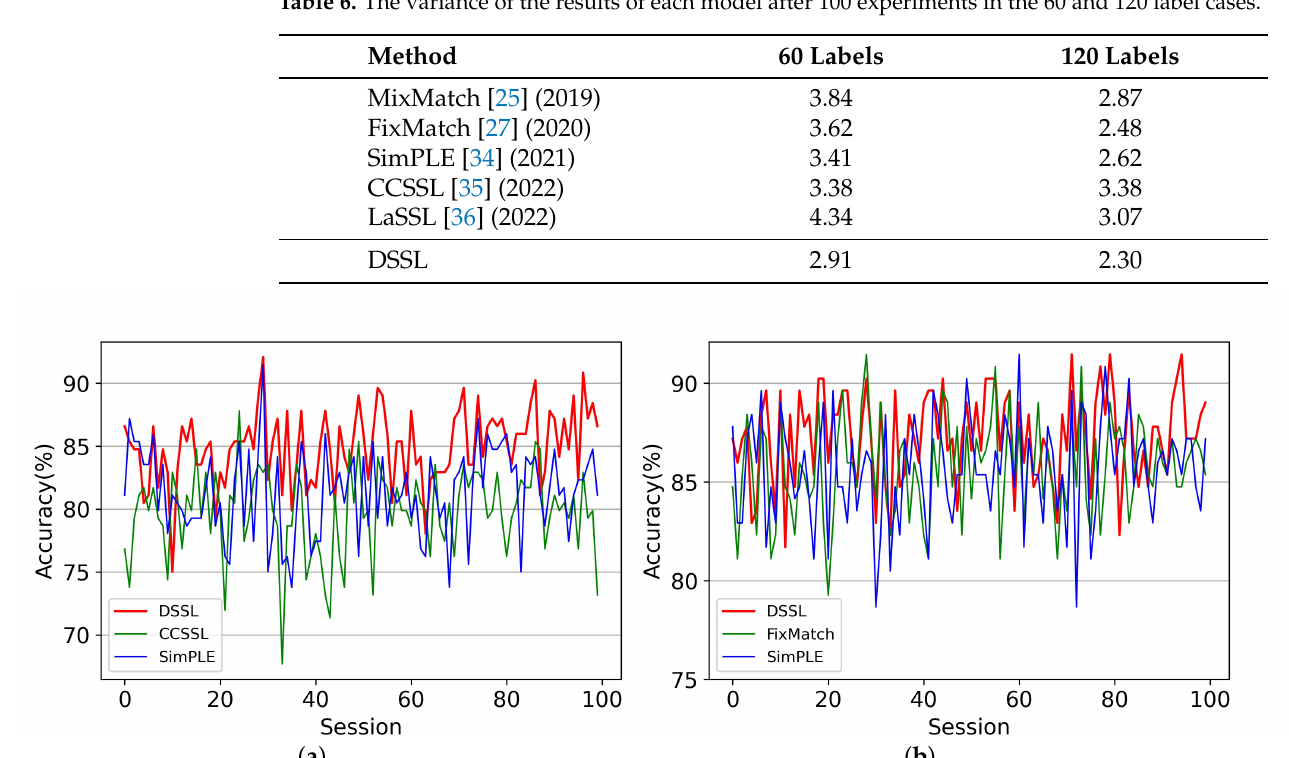
Table 6. The variance of the results of each model after 100 experiments in the 60 and 120 label cases.